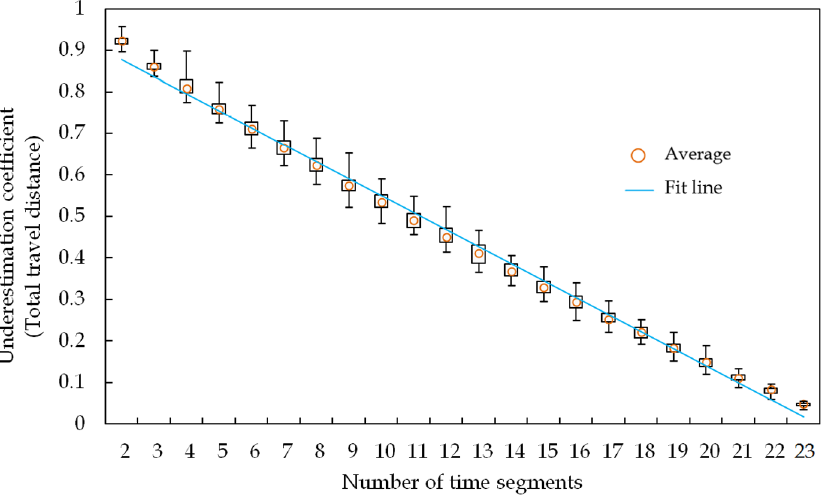
Figure 10. Distribution of aggregated underestimation coefficients for estimating total travel distance using different numbers of time segments.